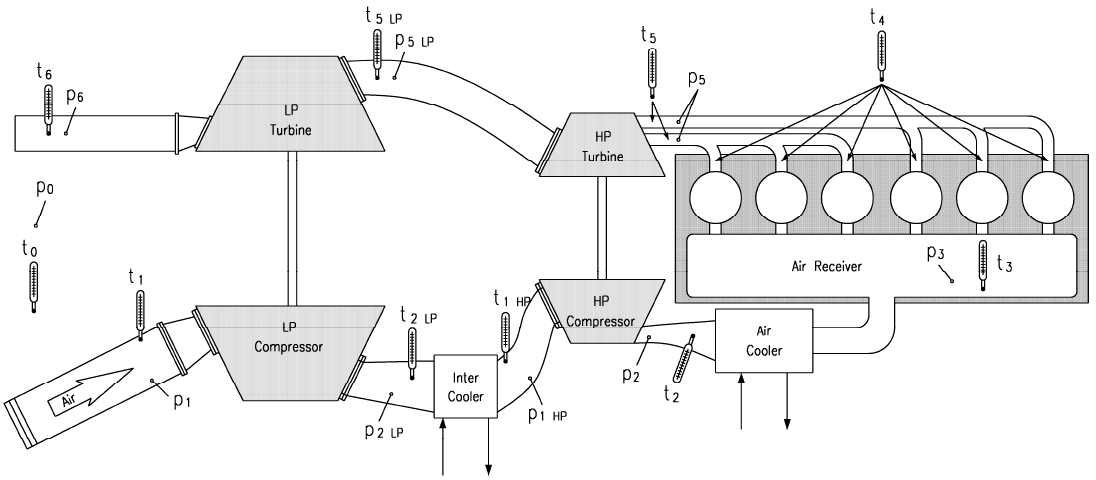
Figure A3. Modified WIT convention: Double-stage case.